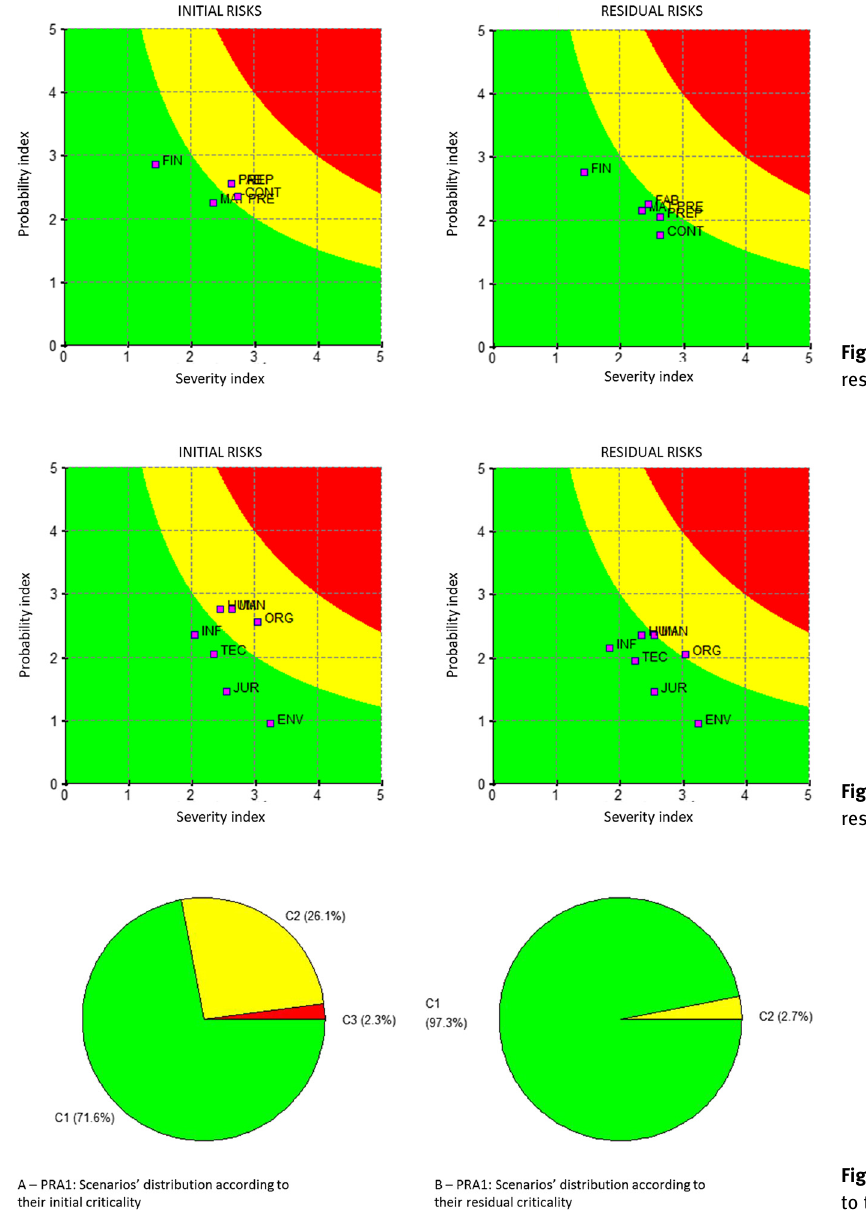
Figure 5: Scenarios ’ distribution according to their criticality for